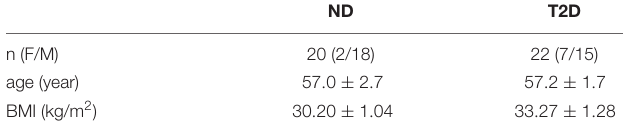
purchased from Lifespan Biosciences (Seattle, WA, United States) (sensitivity = 1.56 ng/mL, intra-assay CV = 5.4%), while Wnt 4 was measured by an ELISA kit from Ray Biotech (Norcross, GA) (sensitivity = 1.22 ng/mL, intra-assay CV < 10%).